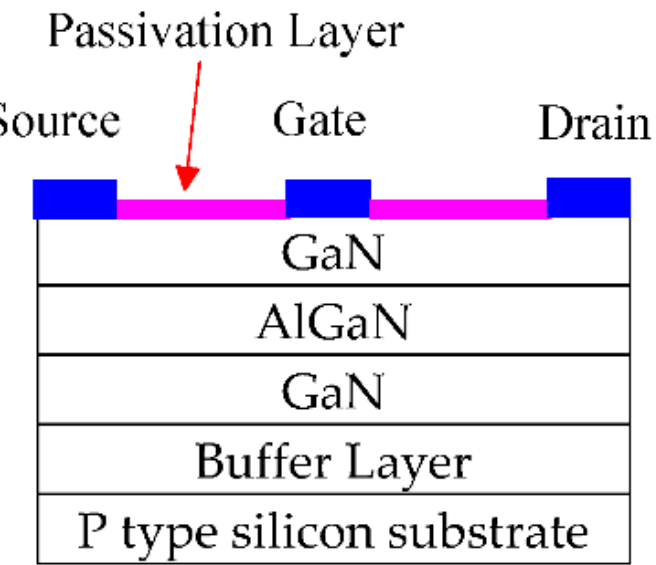
Figure 1. Cross section of the studied passivated AlGaN/GaN high-electron mobility transistor (HEMT).